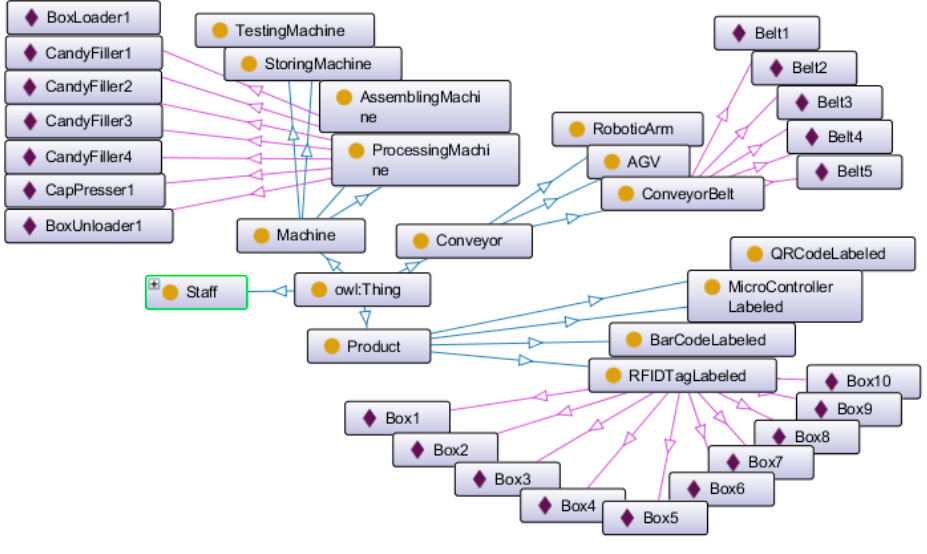
Figure 7. Ontology graph.